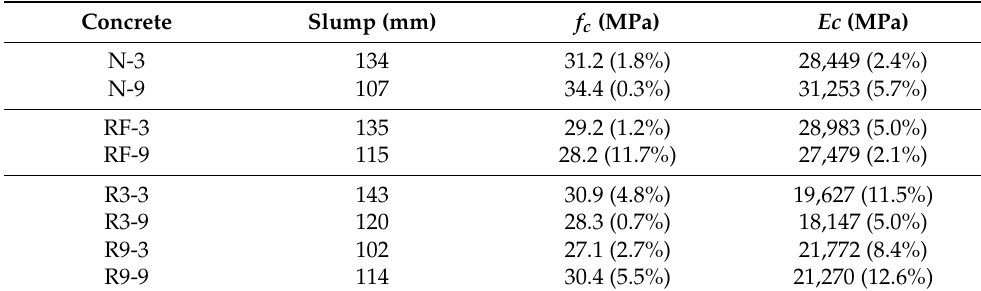
Table 4. The concrete basic properties.